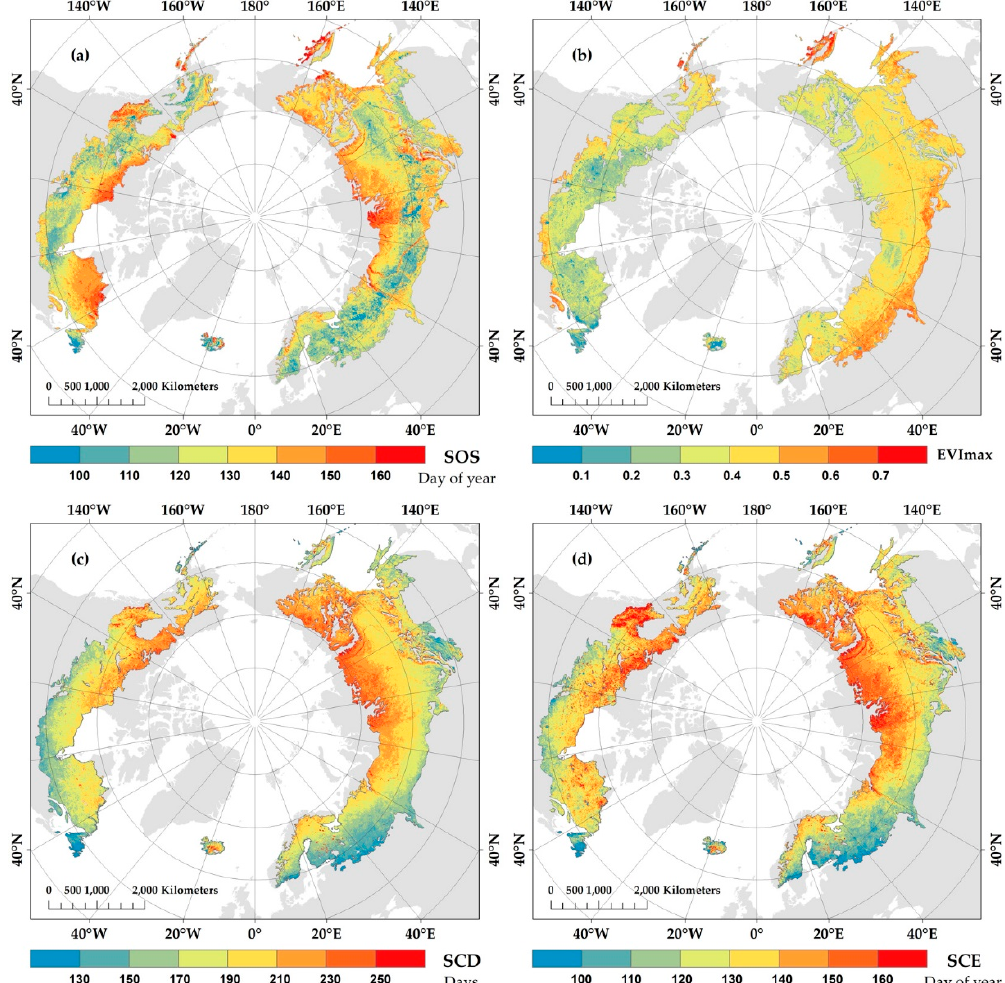
Figure 2. Averages of the start of the growing season (SOS, a ), annual maximum enhanced vegetation index (EVImax, b ), snow cover duration (SCD, c ), and snow cover end date (SCE, d ) across the boreal region.